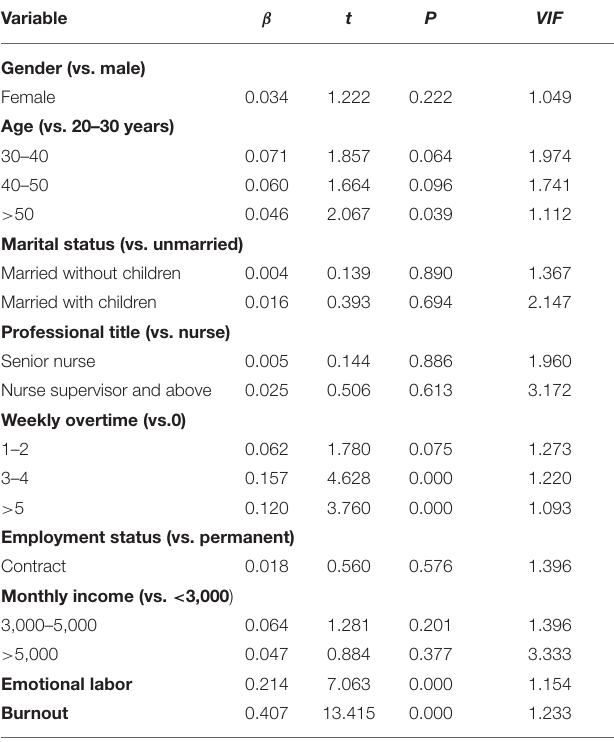
TABLE 3 | Results of multivariable linear regression to predict presenteeism factors.